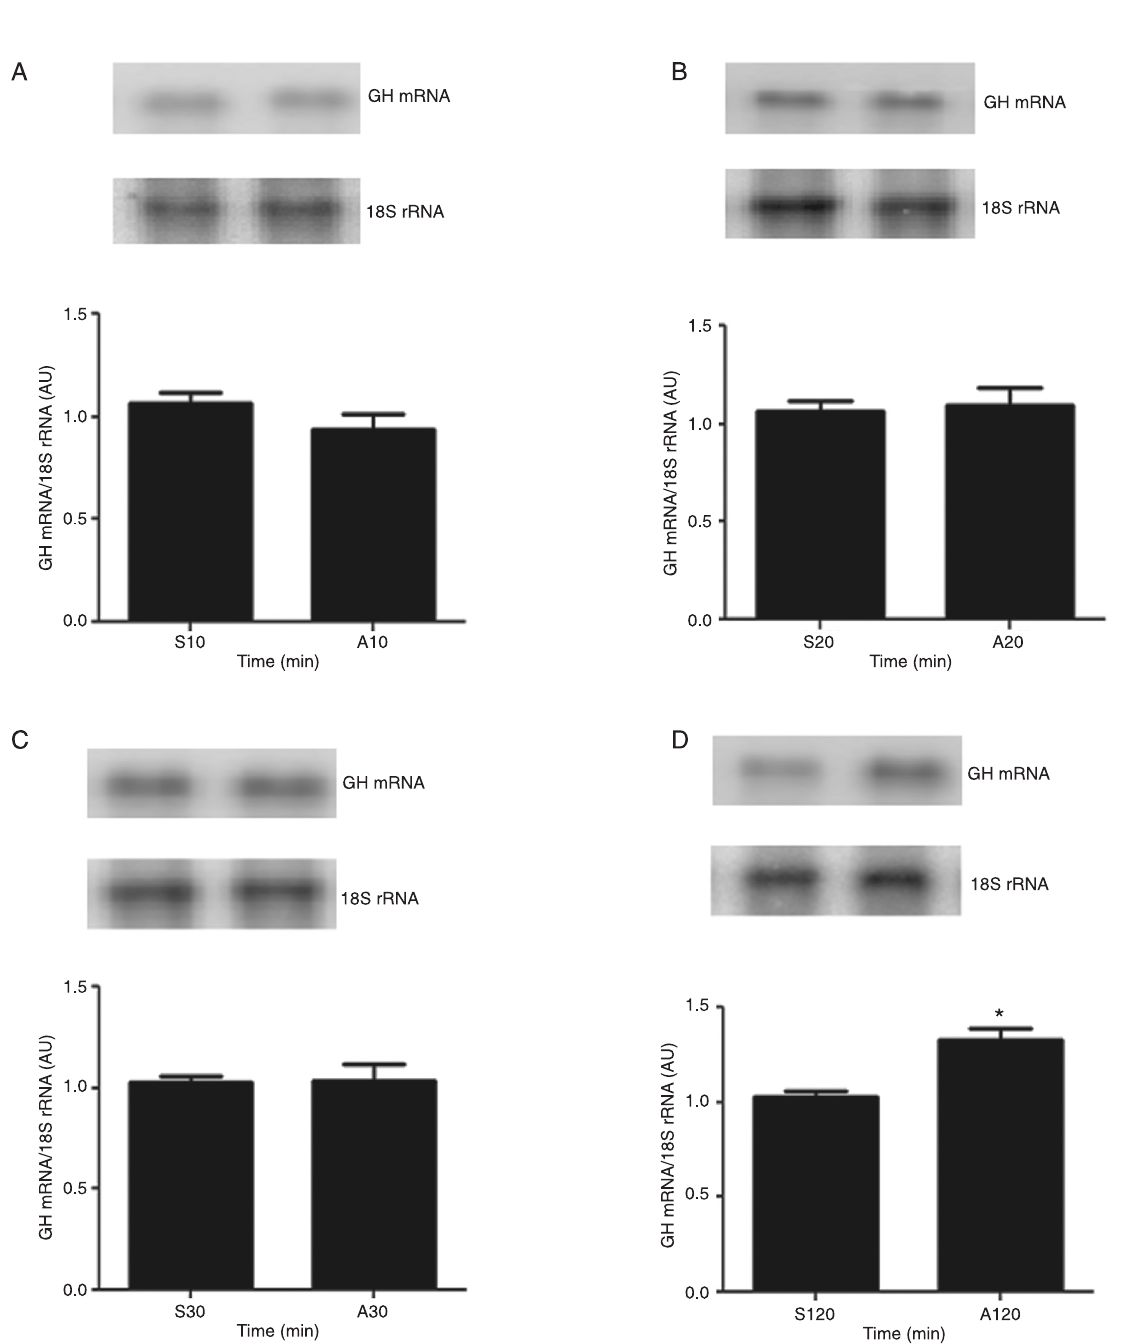
Figure 2. Time-course study of the effect of arginine on growth hormone (GH) mRNA expression. Panels A , B , C , and D present at the top typical autoradiograms of the GH mRNA and 18S abundance obtained in one experiment of a total of three for hemi- pituitaries treated with saline (S) or 71 mM arginine (A) for 10, 20, 30, and 120 min, respectively. The quantitative representation of hybridization of GH and 18S rRNA transcripts obtained in all experiments is shown at the bottom of each panel. Data are reported as means ± SEM in arbitrary units (AU). *P < 0.05 vs saline (Student t